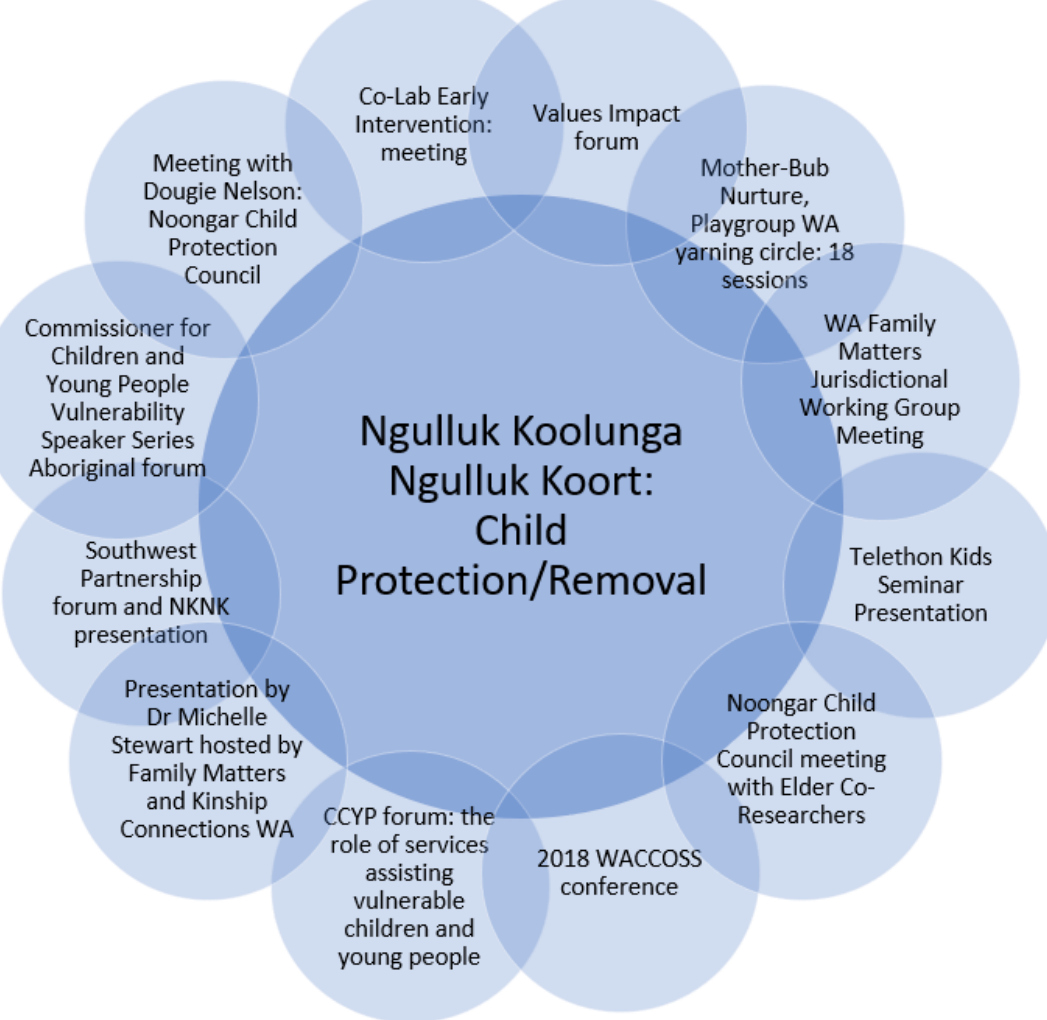
Figure 3. Child protection/removal research translation activities (Reprinted with permission from the Ngulluk Koolunga Ngulluk Koort project, Telethon Kids Institute).